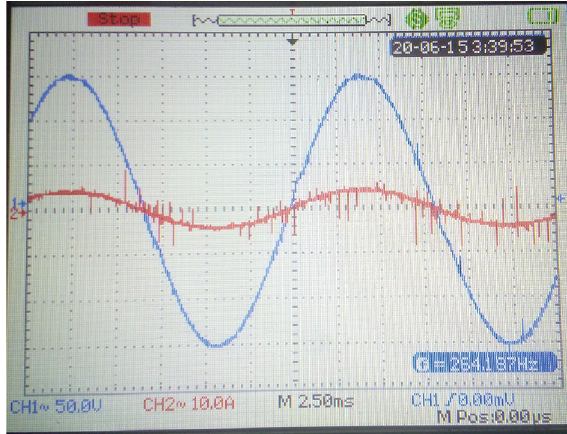
= 180 , VAC = 110 , and THD v = 0 : 5 % . DC